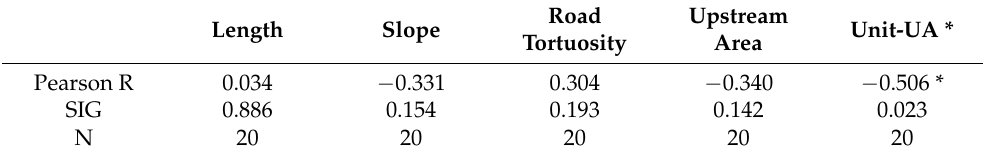
Table 4. The correlation coefficient between model deviation and influential factors. Length